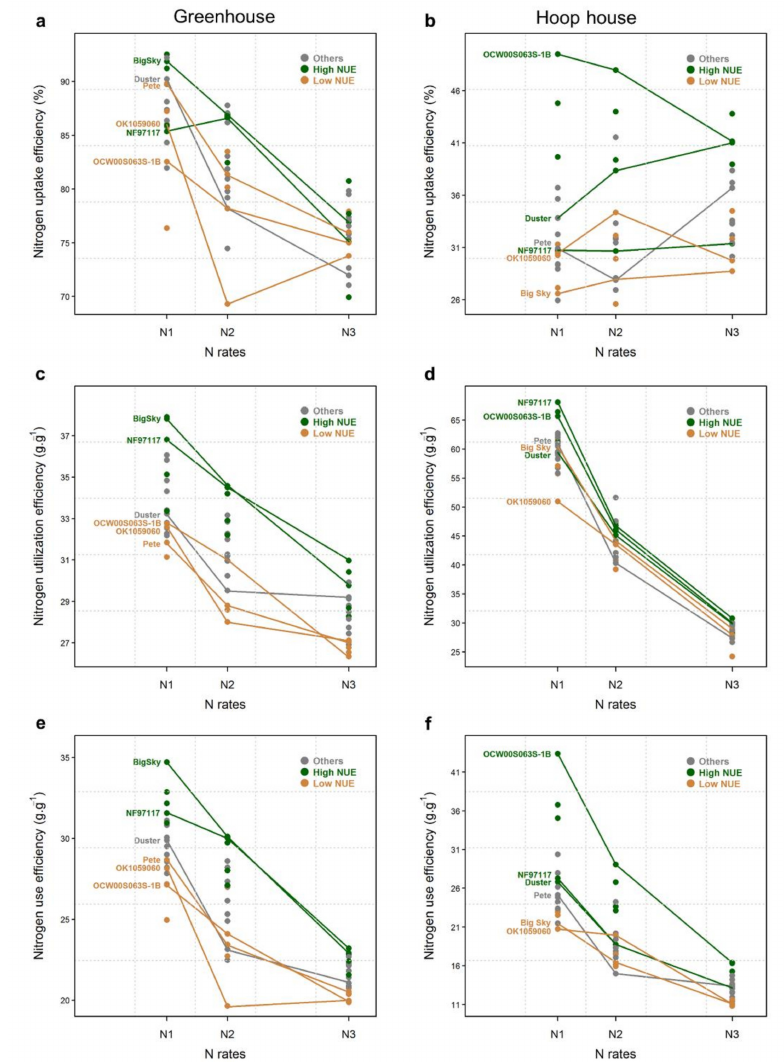
Figure 2. Nitrogen uptake e ffi ciency ( a , b ), nitrogen utilization e ffi ciency ( c , d ), and nitrogen use e ffi ciency ( e , f ) of 20 wheat lines evaluated in greenhouse (left panel) and hoop house (right panel) under three di ff erent N rates. Green and orange points correspond to the six lines with the highest and lowest NUEs, respectively, in each environment, which were also evaluated for root traits. Grey points are all the other